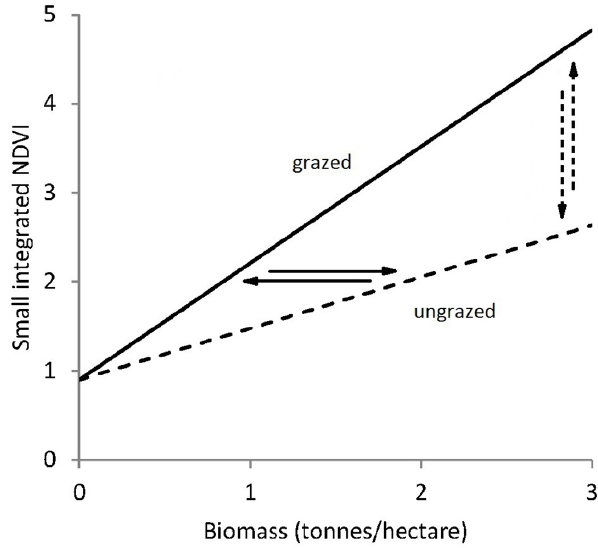
Figure 5. Conceptual figure illustrating the potential effect of graz- ing on the relationship between small integrated NDVI and ESSB.